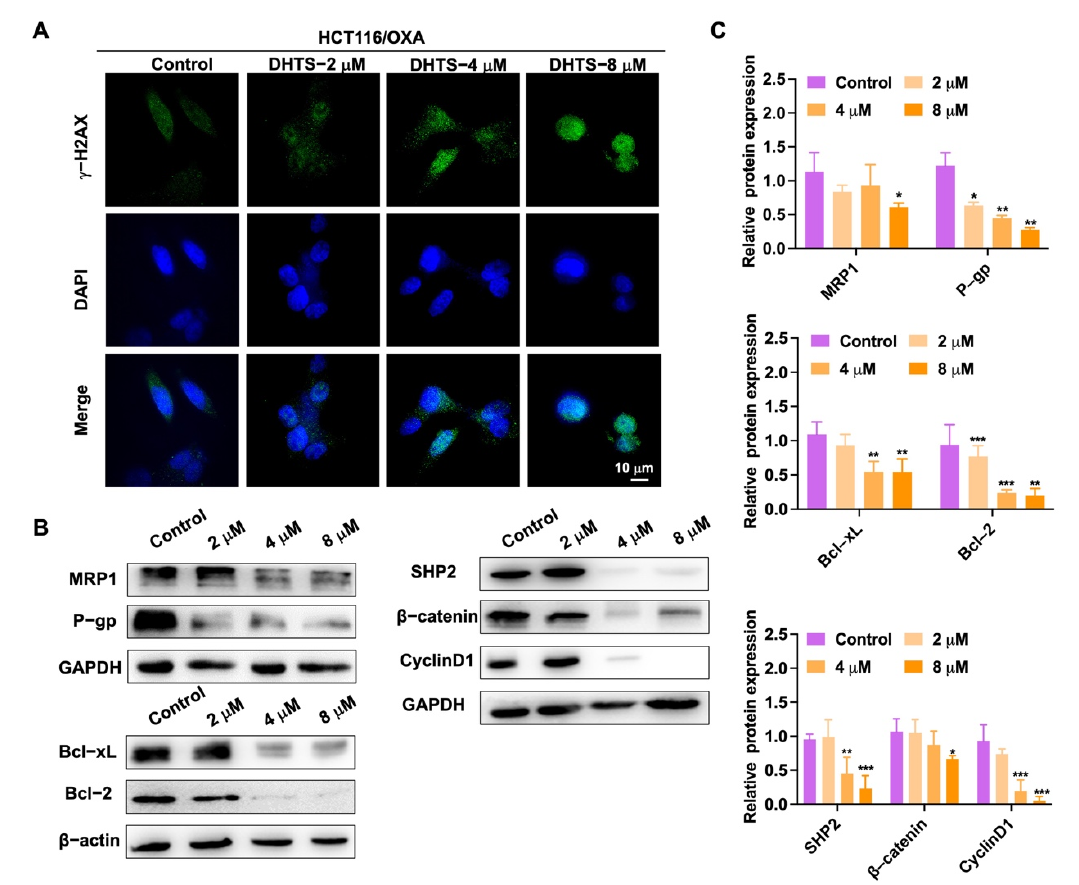
Figure 6. DHTS suppresses the growth of H116/OXA cells in vitro. ( A ) HCT116/OXA cells were treated with DHTS at 2, 4, and 8 μ M for 48 h by immunofluorescence; ( B ) effects of DHTS on different proteins in drug-resistant strain HCT116/OXA; ( C ) quantitative analysis of western blot in Figure 6B (compared to the control group, * p < 0.05, ** p < 0.01, *** p <0.001).